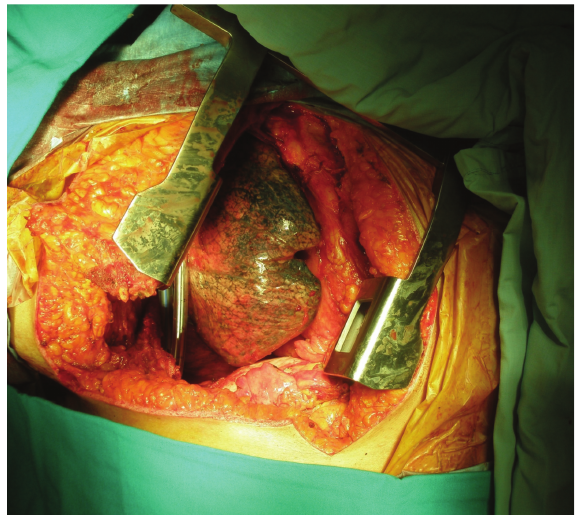
Figure 4: Hemiclamshell incision can be observed after removal of the tumor. A separator was placed on borders of the sternotomy incision.